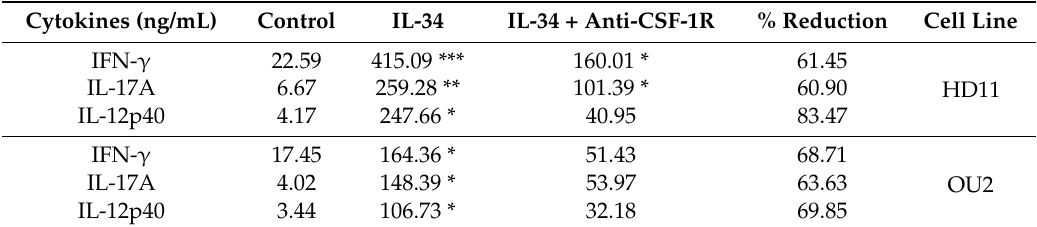
Table 1. Colony-stimulating factor receptor (CSF-1R) neutralization with a CSF-1R antibody decreased recombinant chicken IL-34 (chIL-34)-induced cytokine production in chicken cell lines. Cytokines (ng/mL) Control